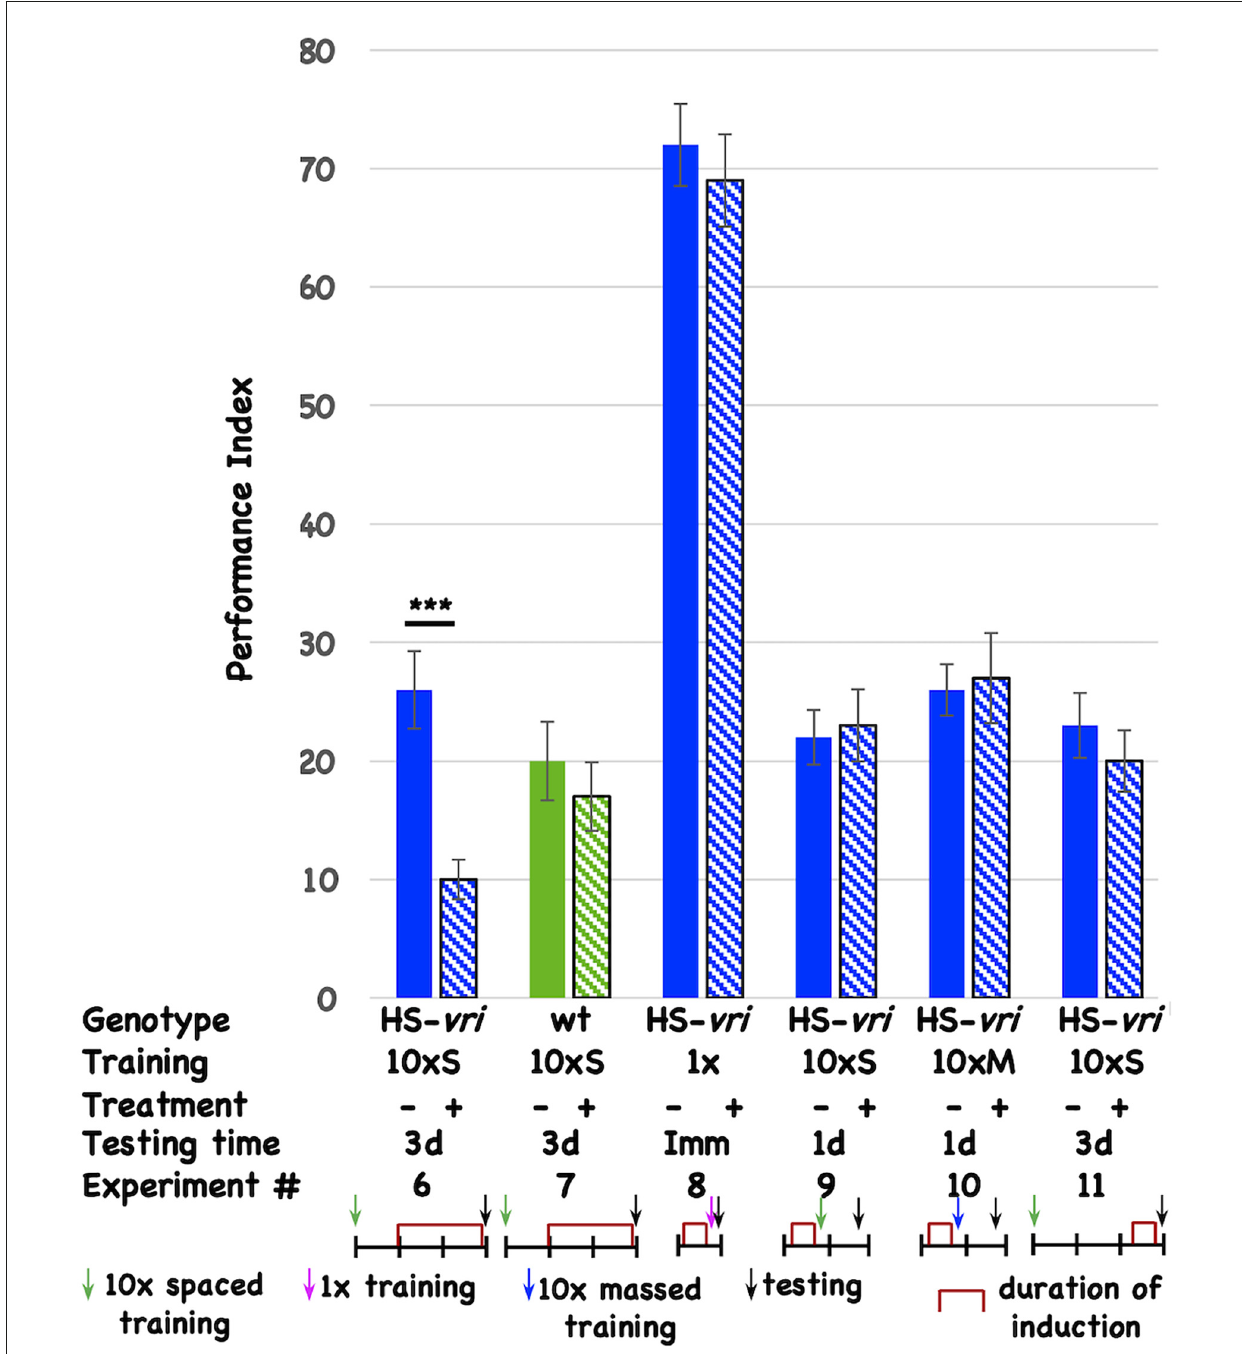
FIGURE2 Inductionof vrille specificallydisrupts3dmemory.Theperformanceoffliesisplottedasafunctionofgenotype,typeofbehavioraltraining,treatment, and testing time. There are two genotypes of flies: HS- vri transgenic (histograms in blue or blue stripes) and otherwise isogenic “wild-type” ( w 1118 , histograms in green or green stripes) flies in which the transgene resides. The performance of flies not induced is shown with solid histograms while that of flies that undergo heat-shock induction is shown in stripes. Underneath the behavioral data, the different experiments are assigned a number, and the details of each Experiment are shown in tabular and cartoon formats. In the table, the top line indicates the genotype of the flies that are used for each experiment. 10 × S indicates flies that receive 10 cycles of spaced training. 1x denotes flies that only undergo a single training trial. 10 × M corresponds to flies that receive 10 cycles of massed training. The — sign denotes no treatment, while the + sign shows data for flies that were induced with a mild, chronic heat-shock (20 ◦ C to 28 ◦ C shift). The different testing times are denoted as 3d (3-day memory), Imm (immediate performance after a single cycle of training), or 1d (24 h memory). In the cartoon portion of the Figure, the horizontal line denotes the timeline of the experiment, and each vertical tick mark represents 1d of elapsed time. Green, magenta, and blue arrows indicate whether flies received 10 cycles of spaced training, a single cycle of training, or 10 cycles of massed training. The black arrows indicate the time of testing. The red brackets show when the heat-shock induction occurred. The color scheme used for the data histograms (top of Figure) is unrelated to the one used in the cartoons (bottom part of Figure). N = 8 for all experiments, T -tests were used to evaluate significance. *** p < 0.001. All unmarked pairwise comparisons are not significantly